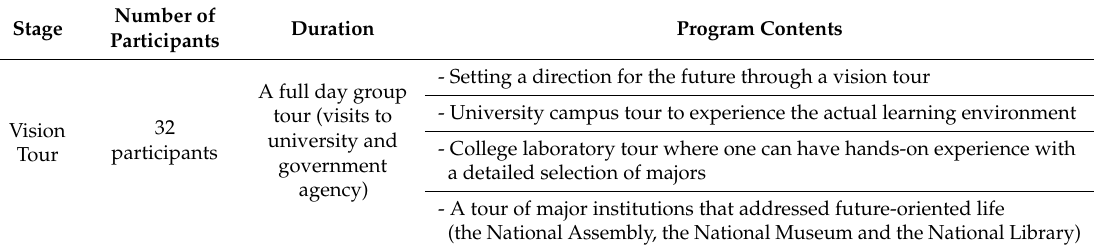
Table 5. Details of the Vision